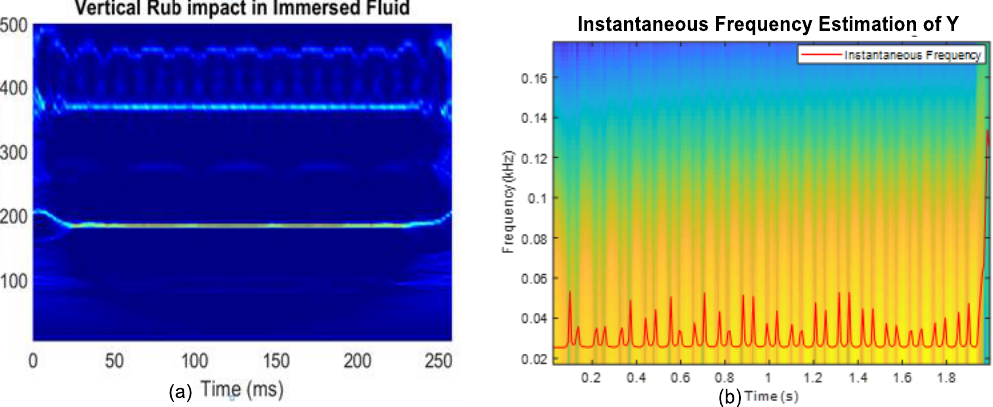
Figure 20. Time-frequency map of imbalanced drill string-casing rub in fluid; ( a ) NWSST response; ( b ) IF response.